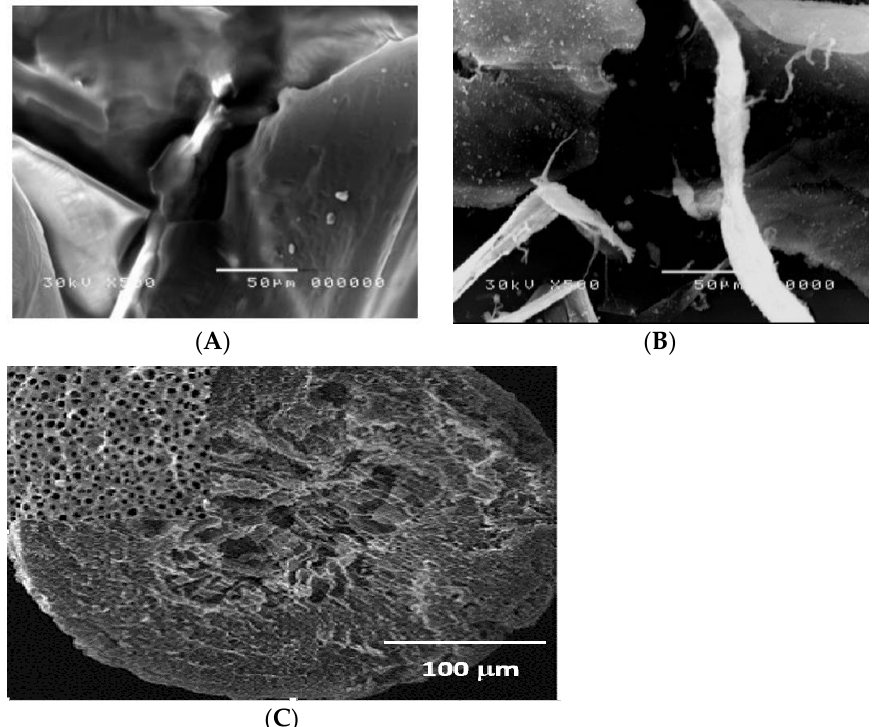
Figure 7. SEM micrographs for ( A ) chitin, ( B ) chitosan, and ( C ) Ch/g-HNTs@Zn M composite.